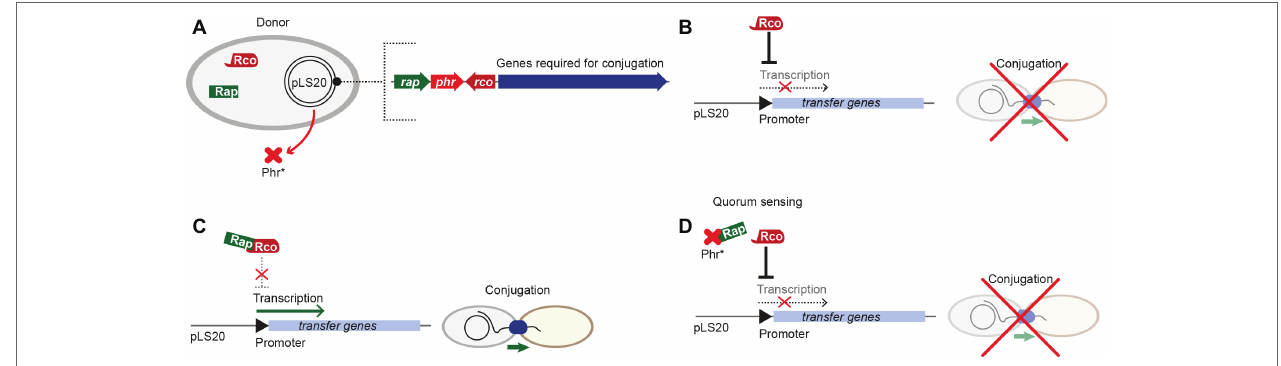
FIGURE 4 | Regulation of pLS20 conjugative transfer. (A) Key players involved in regulation are encoded on the pLS20 plasmid, including the master regulator Rco LS20 and the Rap LS20 -Phr LS20 sensor-pheromone cassette upstream of genes required for conjugation. (B) The master regulator Rco LS20 represses transcription of transfer genes, thus ultimately inhibiting conjugation. (C) Binding of Rap LS20 to the master regulator Rco LS20 leads to conformational changes of Rco LS20 , interfering with transcriptional repression of transfer genes, thus conjugation can take place. (D) Upon a distinct pheromone concentration (the quorum), the pheromone Phr* LS20 interacts with Rap LS20 and interferes with its binding to the master regulator Rco LS20 . In consequence, Rco LS20 represses transcription of transfer genes and inhibits